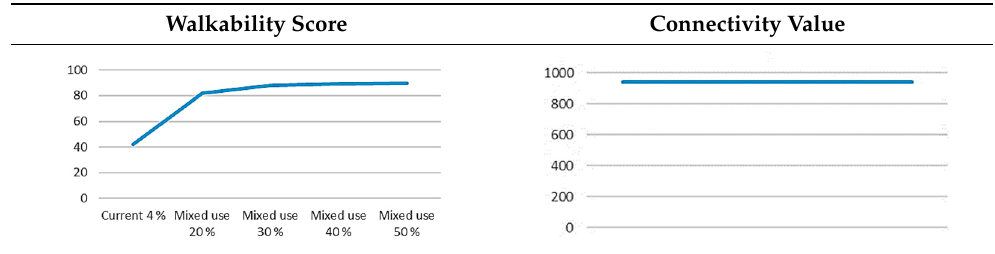
Table 5. Comparative analysis for the walkability and connectivity value results for the different mixed-use scenarios.